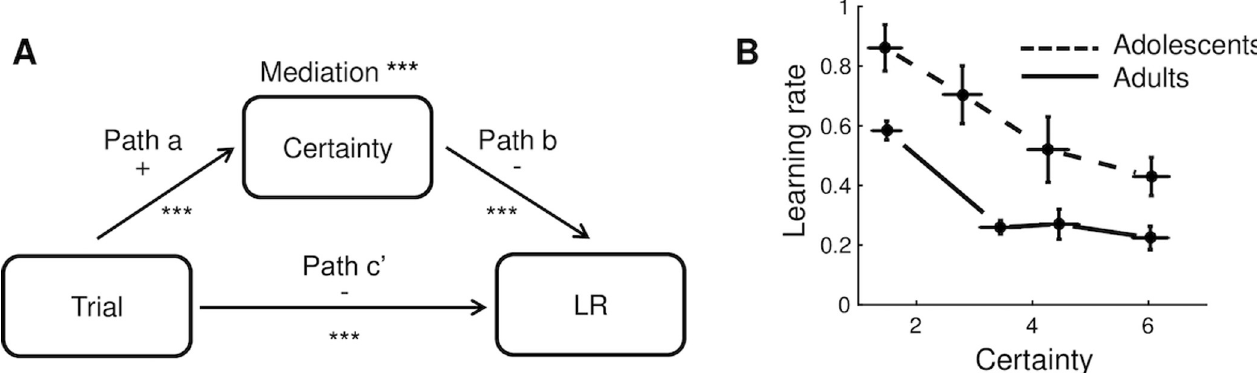
Fig 3. Relationships between trial number, certainty rating and learning rate during the estimation task. A . Mediation model and results. LR = learning rate. ��� p < .001. B . Learning rate as a function of certainty rating and age group. We divided each participant’s learning rates into four bins according to their trial-specific certainty ratings, and plotted the group-average data for each bin, separately for each age group. Note that we binned the data for plotting purposes, but used single-trial measures in our statistical analyses. Error bars indicate standard errors.